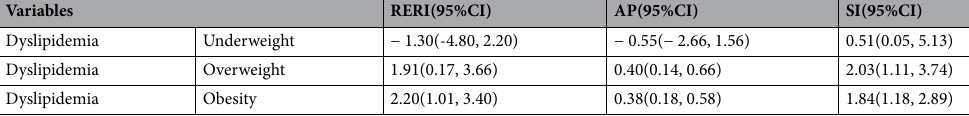
Table 4. Indicators of interaction between BMI and dyslipidemia. RERI: the relative excess risk due to interaction; AP: attributable proportion due to interaction; SI: the synergy index.